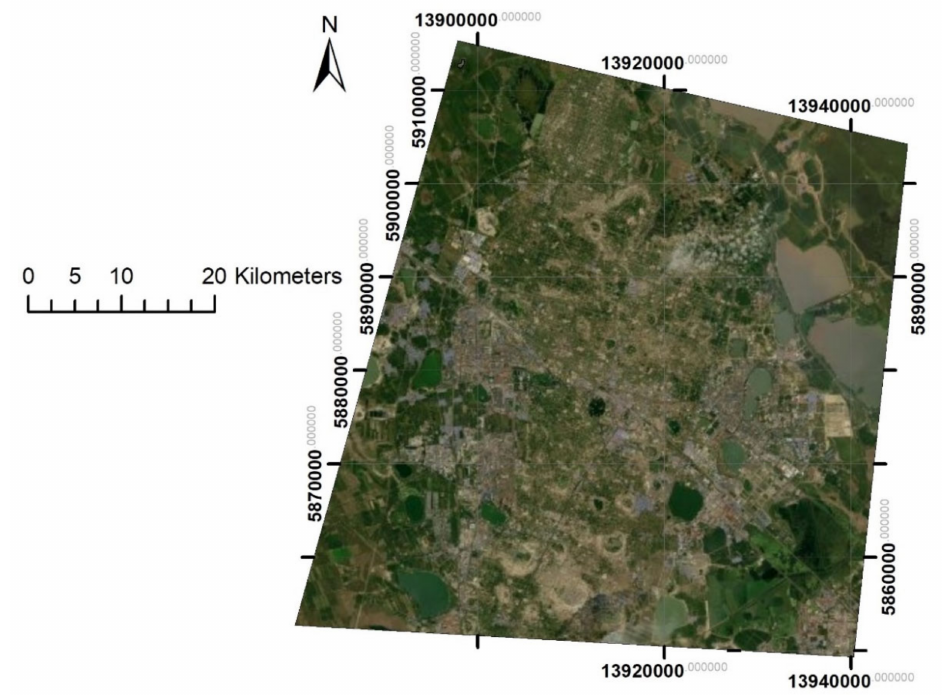
Figure 3. Area of Daqing considered for the mapping and centered around the oil field. This latter is identifiable through the numerous light color patches. Picture from the World Imagery of